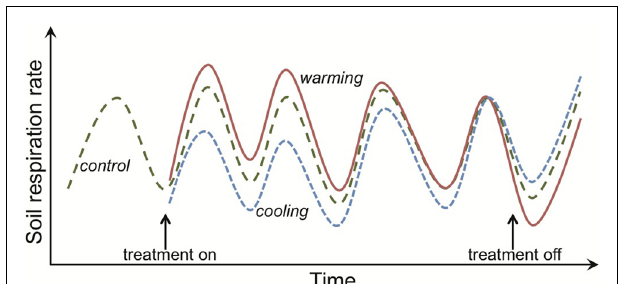
FIGURE 1 | Response of soil respiration to experimental warming or cooling across time in a mesic, temperate system. The rates shown are not observations for any one experiment, but instead are intended to capture characteristic dynamics in respiration responses to warming.The hatched green line depicts respiration from control plots, where each unimodal cycle represents the expected increase in respiration rates across the growing season and then decline as plants senesce. Rates represent both autotrophic and heterotrophic respiration, and so higher rates in the growing season result from multiple mechanisms, including direct temperature effects on respiration and indirect effects such as higher plant-carbon supply to heterotrophic microbes. Similar dynamics would be expected for only heterotrophic respiration given that temperatures are higher during the growing season and the common assumption of a constant substrate supply, making it hard to disentangle the mechanisms underlying apparent thermal acclimation (see main text). Initiation of the warming treatment (e.g., a 5 ◦ C increase above ambient; depicted by the red solid line) stimulates soil respiration but this augmentation is ephemeral, with rates in the warming plots being equivalent to the controls by the fourth treatment year.This apparent thermal acclimation could arise through physiological adaptation of the organisms and/or changes in the environment, such as depletion of substrate that supports microbial activity. Both types of mechanism result in respiration rates in warmed plots that are lower than in controls if the treatment is discontinued.The opposite respiration response is observed for experimental cooling (blue dotted